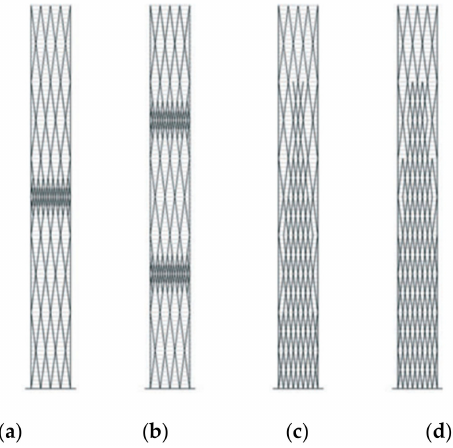
Figure 10. Variable-density (VD) patterns proposed by Angelucci and Mollaioli [9]: ( a ) and ( b ) concentrated outrigger-like VD pattern; ( c ) and ( d ) distributed VD pattern. Used with permission from Angelucci and Mollaioli